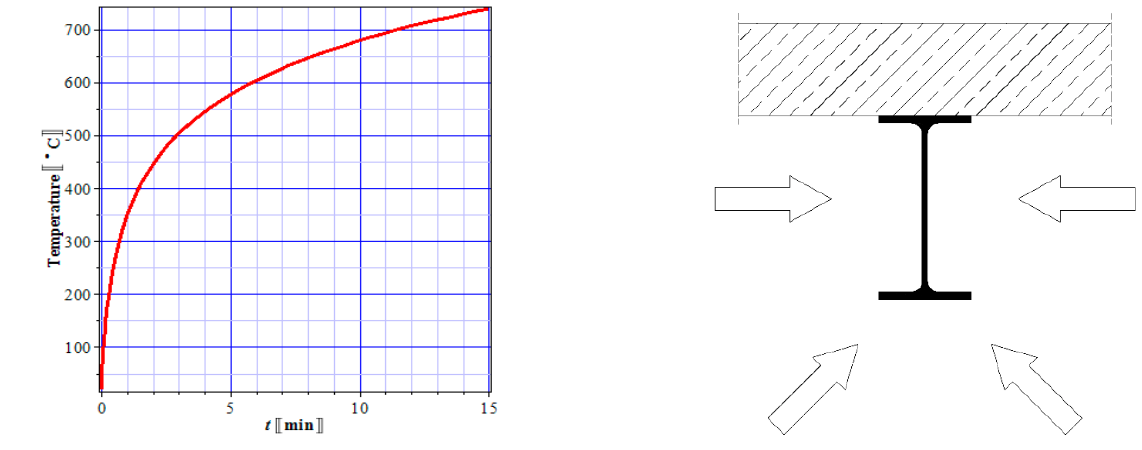
Figure 5. Cross-sectional dimensions (left graph) and beam meshing scheme (right graph).